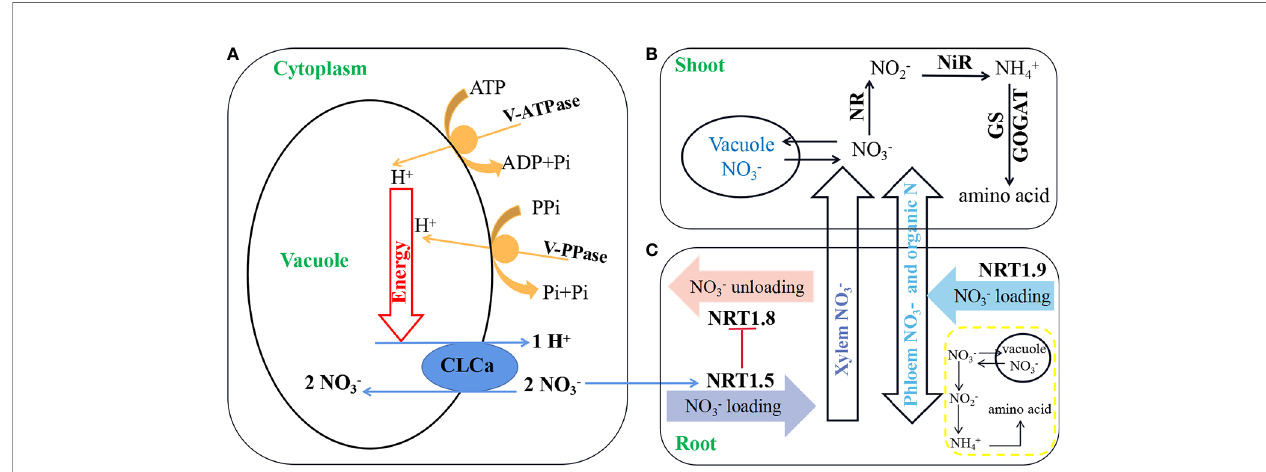
FIGURE 1 | A model of short-distance distribution and long-distance transport of NO 3 − in plants. Modi fi ed from Zhang (2017). (A) Accumulation of NO 3 − in the vacuole is regulated by chloride channels (CLCa) and relies on an H + gradient established by V-ATPase and V-PPase. (B) Short-distance distribution of NO 3 − and reactions catalyzed by NO 3 − reductase (NR), nitrite reductase (NiR), glutamine synthetase (GS), and glutamate synthase (GOGAT) in shoots. (C) Long-distance transport of